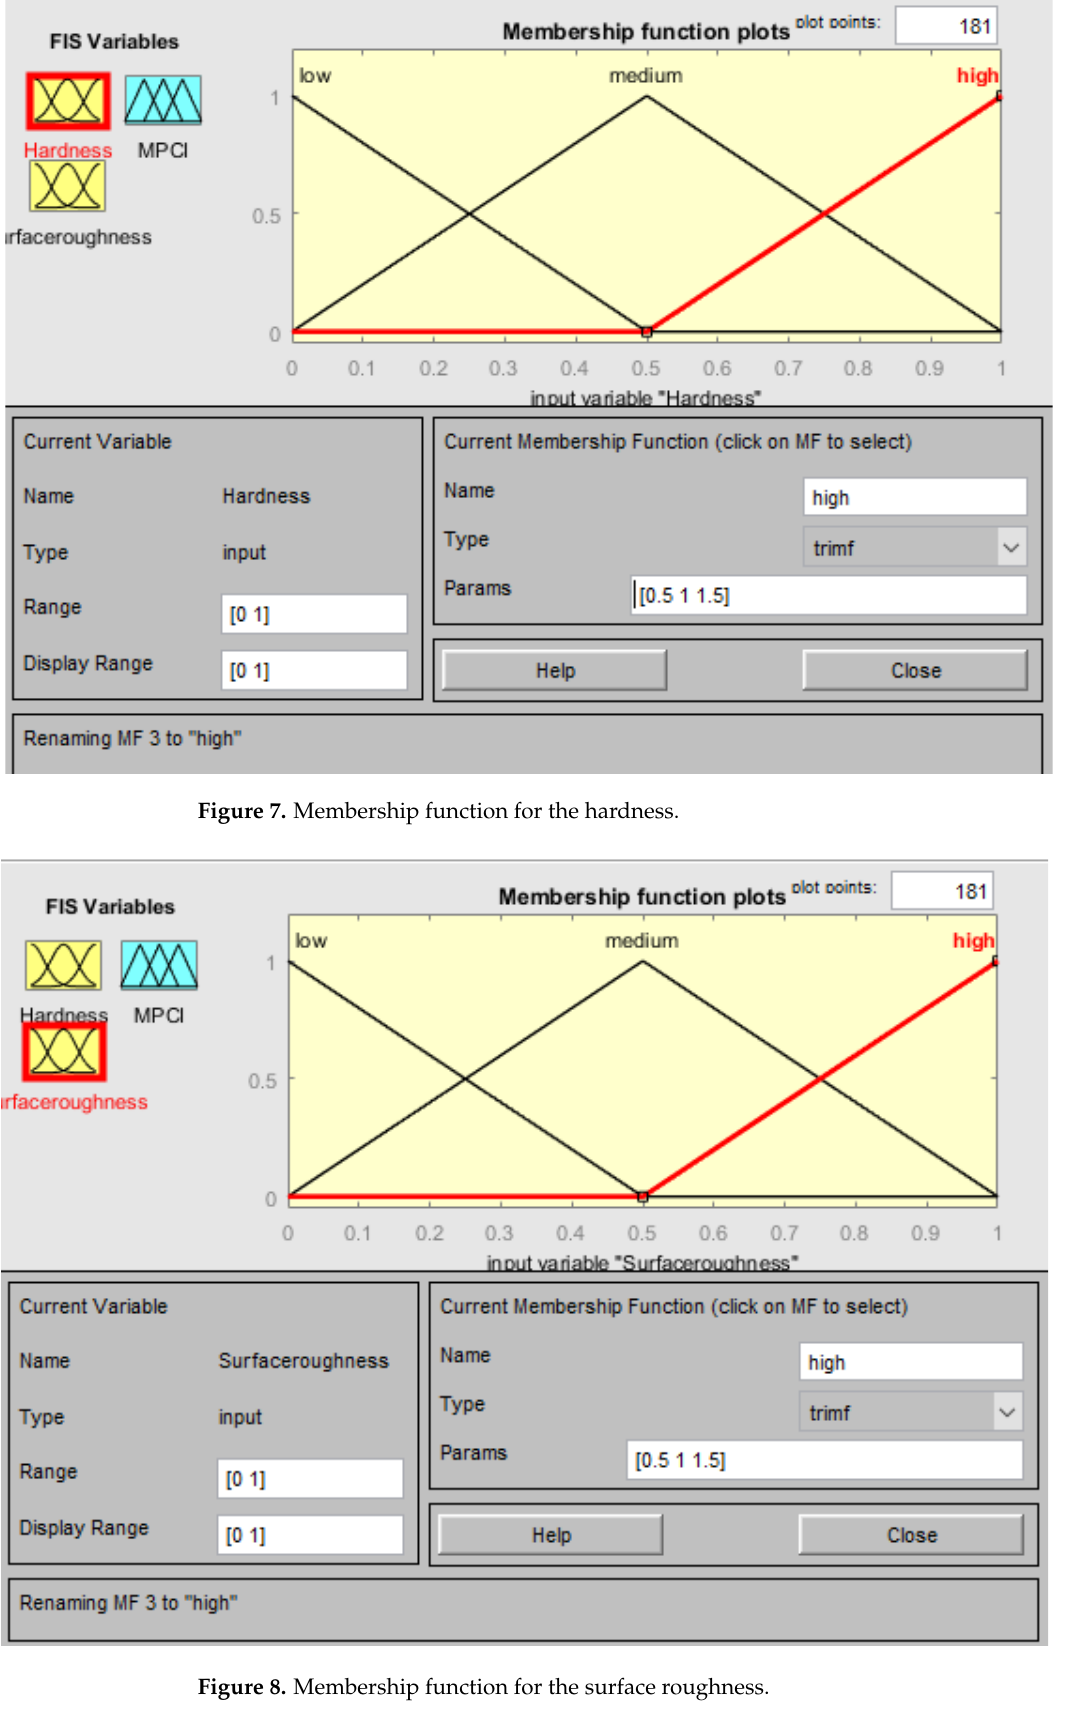
Figure 9. Membership function for the MPCI.